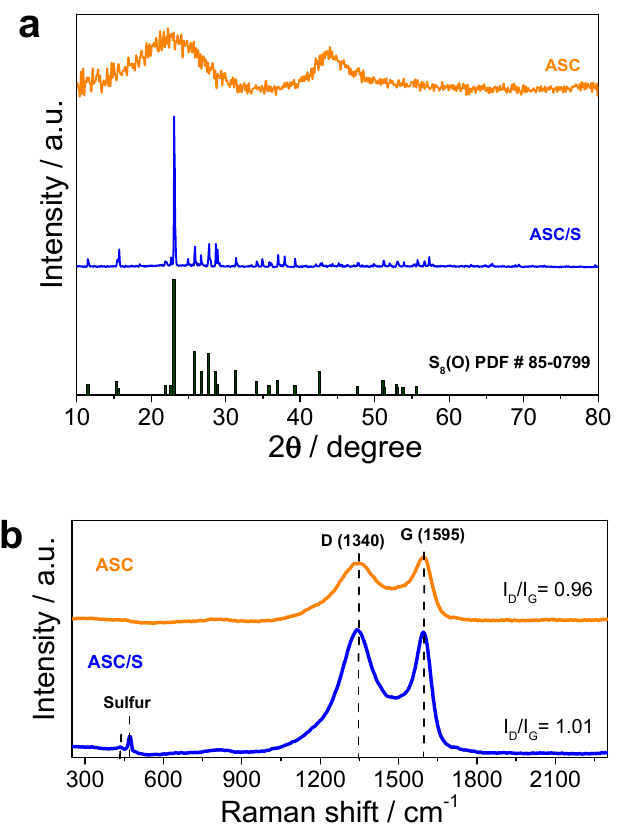
Figure 4. ( a ) XRD pattern and ( b ) Raman spectra of ASC and ASC/S composite.